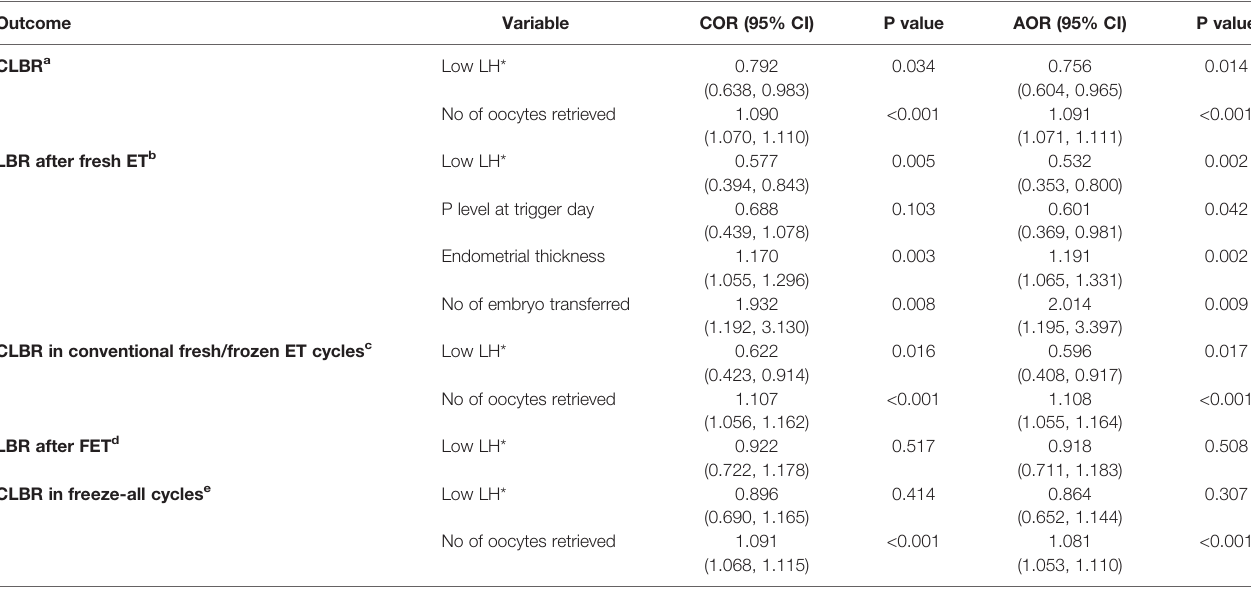
*ToevaluatetheLHeffectonpregnancyoutcomes,thehigherLHgroupwastakenasreference. a AdjustedforETstrategy(freshvs.freeze-all),femaleage,infertilityduration, baselineFSH andLHlevels,totalGndose,doseofGnRHantagonistsandrLHsupplementation,E 2 levelsattriggerday,andoocytescount. b AdjustedfordoseofGnRH antagonists,progesteroneand LHlevelsattriggerday,endometrialthicknessattriggerday,andnumberofembryostransferred. c AdjustedfordoseofGnRHantagonists,typeanddurationofinfertility,baselineLHlevels, E 2 and LH levels at trigger day, and oocytes count. d Adjusted for the total Gn dose, dose of rLH supplementation, E 2 levels at trigger day, oocytes count, number and stage of embryos transferred. e Adjusted for female age, duration of infertility, baseline FSH and LH levels, dose of Gn and rLH supplementation, E 2 levels at trigger day, and oocytes count. CLBR, cumulative live birth rage; LBR, live birth rate; FET, frozen-thawed embryo